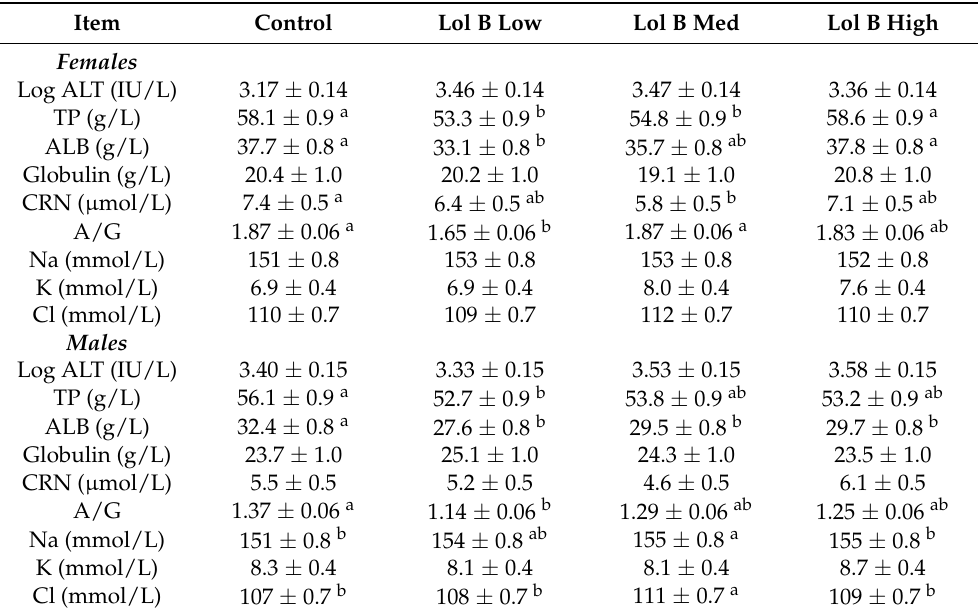
Table 8. Blood chemistry of mice fed control, lol B low, lol B med or lol B high diets (containing 0,